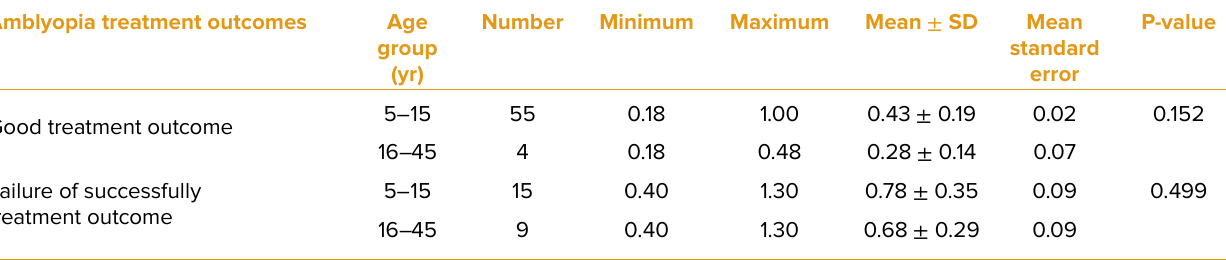
Table 1. The comparison of the pretreatment of corrected distance visual acuity (LogMAR) between children and adult groups, based on amblyopia treatment outcomes in anisometropic amblyopic patients. Amblyopia treatment outcomes